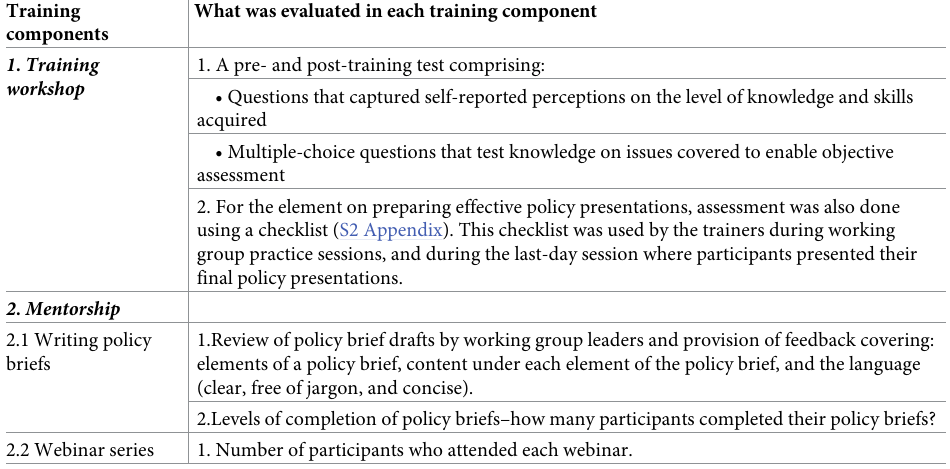
Table 5. What was evaluated in the training